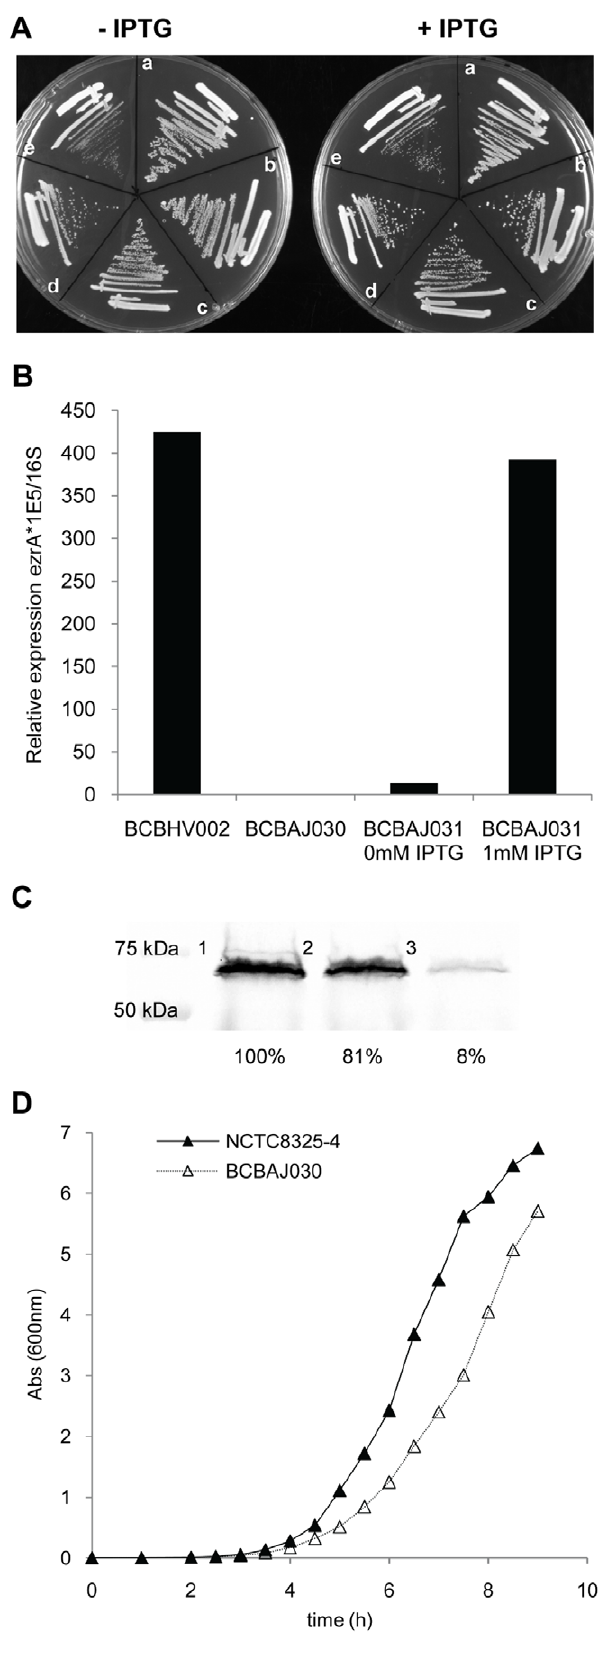
Figure 1. EzrA is not essential in S.aureus . (A) Bacterial strains with ezrA under the control of inducible P spac promoter, grown on solid medium (TSA) supplemented or not supplemented with 1 mM IPTG. (a) BCBAJ036 (RN4220 background); (b) BCBAJ031 (NCTC8325-4 back- ground); (c) BCBAJ034 (SH1000 background); (d) BCBAJ035 (Newman background); (e) BCBAJ019 (COL background). (B) Expression of ezrA transcript in control strain BCBHV002 (NCTC8325-4, lacI ) and in the inducible strain BCBAJ031 (NCTC8325-4 ezrA :: P spac - ezrA , lacI ), grown in the presence and in the absence of IPTG, quantified by RT-PCR and normalized using 16sRNA. (C) Analysis, by SDS-PAGE, of cell lysates of strains BCBAJ012 (COL ezrA :: ezrA-mCherry , lane 1) and BCBAJ024 (COL ezrA :: ezrA-mCherry , containing pBCBAJ006 plasmid expressing ezrA antisense RNA) grown in the presence of glucose 0.2% (w/v) to repress antisense RNA transcription (lane 2), or in the presence of xylose 2% (w/ v) to induce antisense RNA transcription (lane 3). Bands correspond to fluorescence of EzrA-mCherry detected using a FUJI FLA5100 reader. Integrated density for each band is shown below. (D) Growth curve of wild type strain NCTC8325-4 and null mutant BCBAJ030